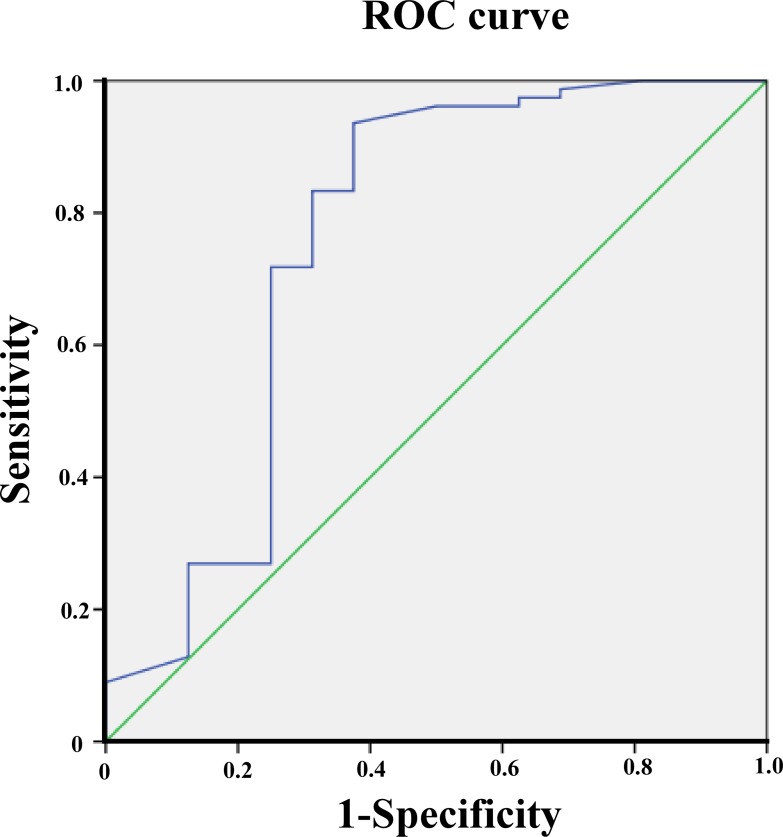
Receiver operating characteristic curve for initial serum troponin-I in predicting the mortality of pediatric myocarditis.The area under the curve was 0.76. The best cutoff value for serum troponin-I was 45 ng/mL (sensitivity, 0.62; specificity, 0.91).